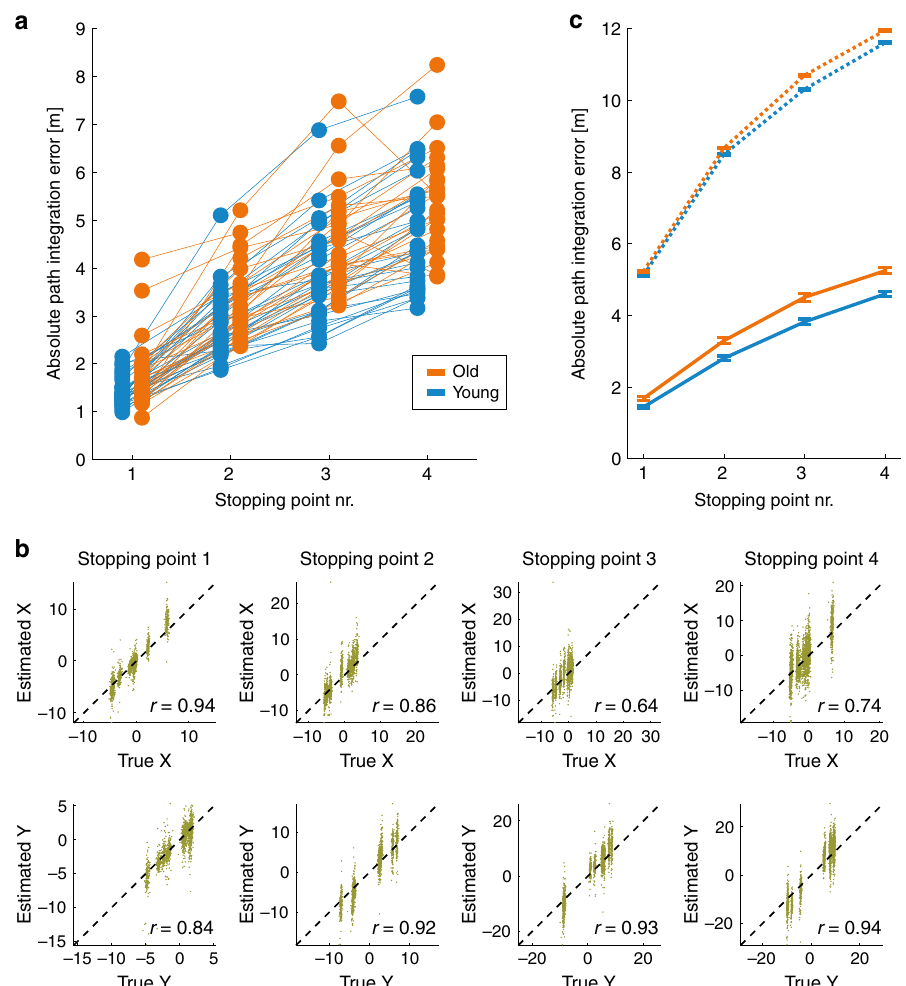
Fig. 2 Path integration performance across both age groups. a Absolute path integration errors over four stopping points for young and older adults. Average errors per stopping point are shown for each participant separately by blue (young adults) and orange (older adults) dots, connected with lines between stopping points. b Each participant ’ s location estimate ( y -axis) versus their true location ( x -axis) at each of the four stopping points (columns), separately for x -coordinates (top row) and y -coordinates (bottom row). Plots show data from all participants and all paths. The diagonal (dashed line) indicates perfect response (estimated location = true location). All correlation coef fi cients are statistically signi fi cant (all p <0.00001). Units are meters. c Absolute path integration errors of young and older adults versus errors with shuf fl ed responses. It is evident that the mean absolute path integration error of both groups (solid lines) is much lower than the errors obtained from shuf fl ing each participant ’ s responses across trials. Error bars indicate group